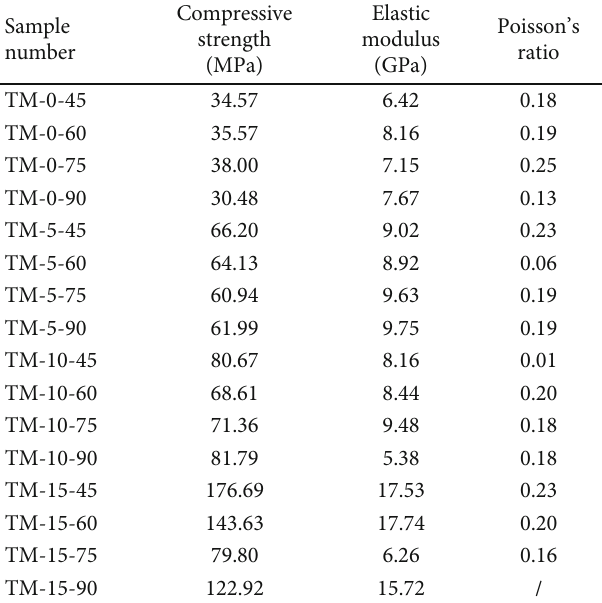
Table 4: T-M coupled tests result of Tamusu clay